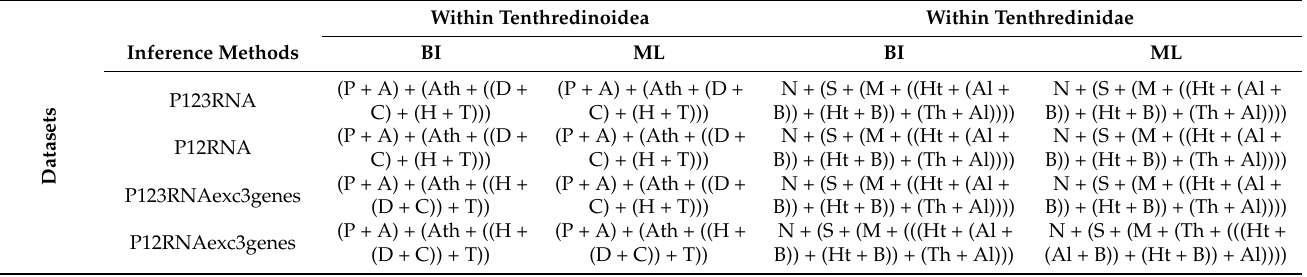
Figure 5. Predicted rrnL secondary structure in the Cladiucha mitochondrial genome. The numbering of helices follows Gillespie et al. [52]. Roman numerals refer to domain names. Tertiary inter-actions and base triples are connected by continuous lines. C. magnoliae as a basemap and base change among Cladiucha species are presented in circles with red ( C. magnoliae ) and pink ( C. punctata ) colors.